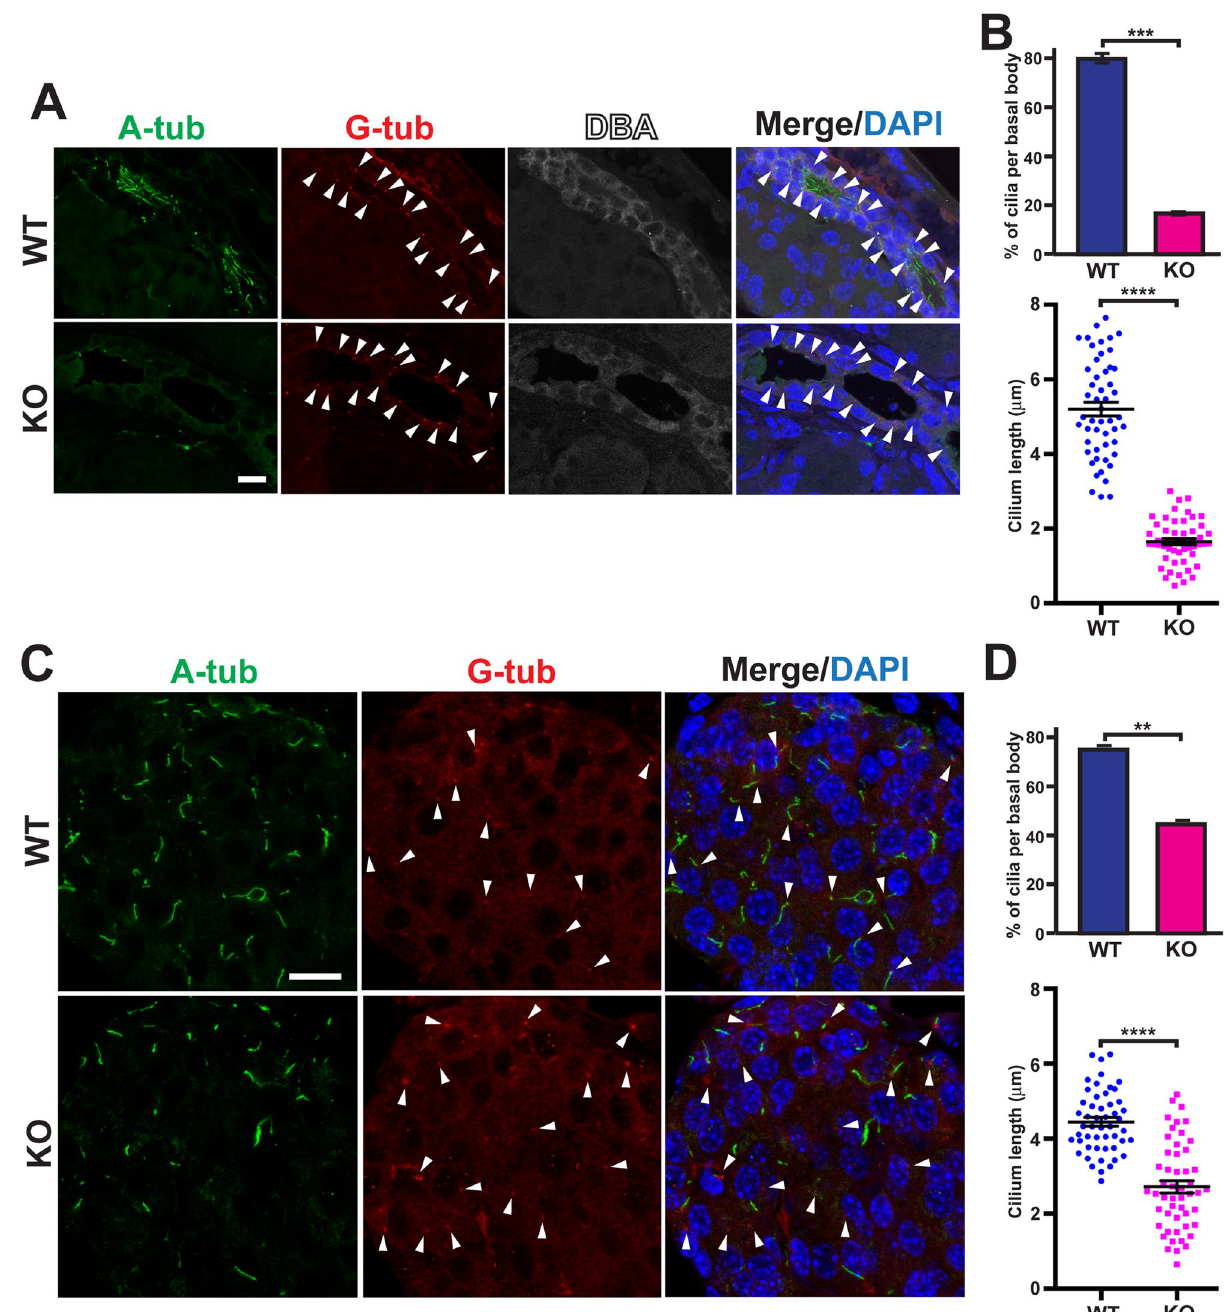
Figure 6. Cby1-KO pancreata show a significant decrease in the number and length of primary cilia. ( A , C ) Pancreatic sections from P18 mice were labeled for A-tub (green), γ-tubulin (G-tub, red), and DBA (white) to evaluate the status of primary cilia in ducts ( A ) and islets ( C ). Nuclei were visualized with DAPI. Arrowheads denote basal bodies. Scale bars, 10 μm. ( B , D ) The number and length of primary cilia were quantified based on results represented in ( A , C ). For the percentage of cilia per basal bodies, data are the average of three independent experiments with n = 70 per category per experiment for each genotype. For quantification of cilium lengths, a total of 51 cilia were quantified per category for each genotype. Data represent means ± SEM. **p < 0.01, ***p < 0.001, ****p <